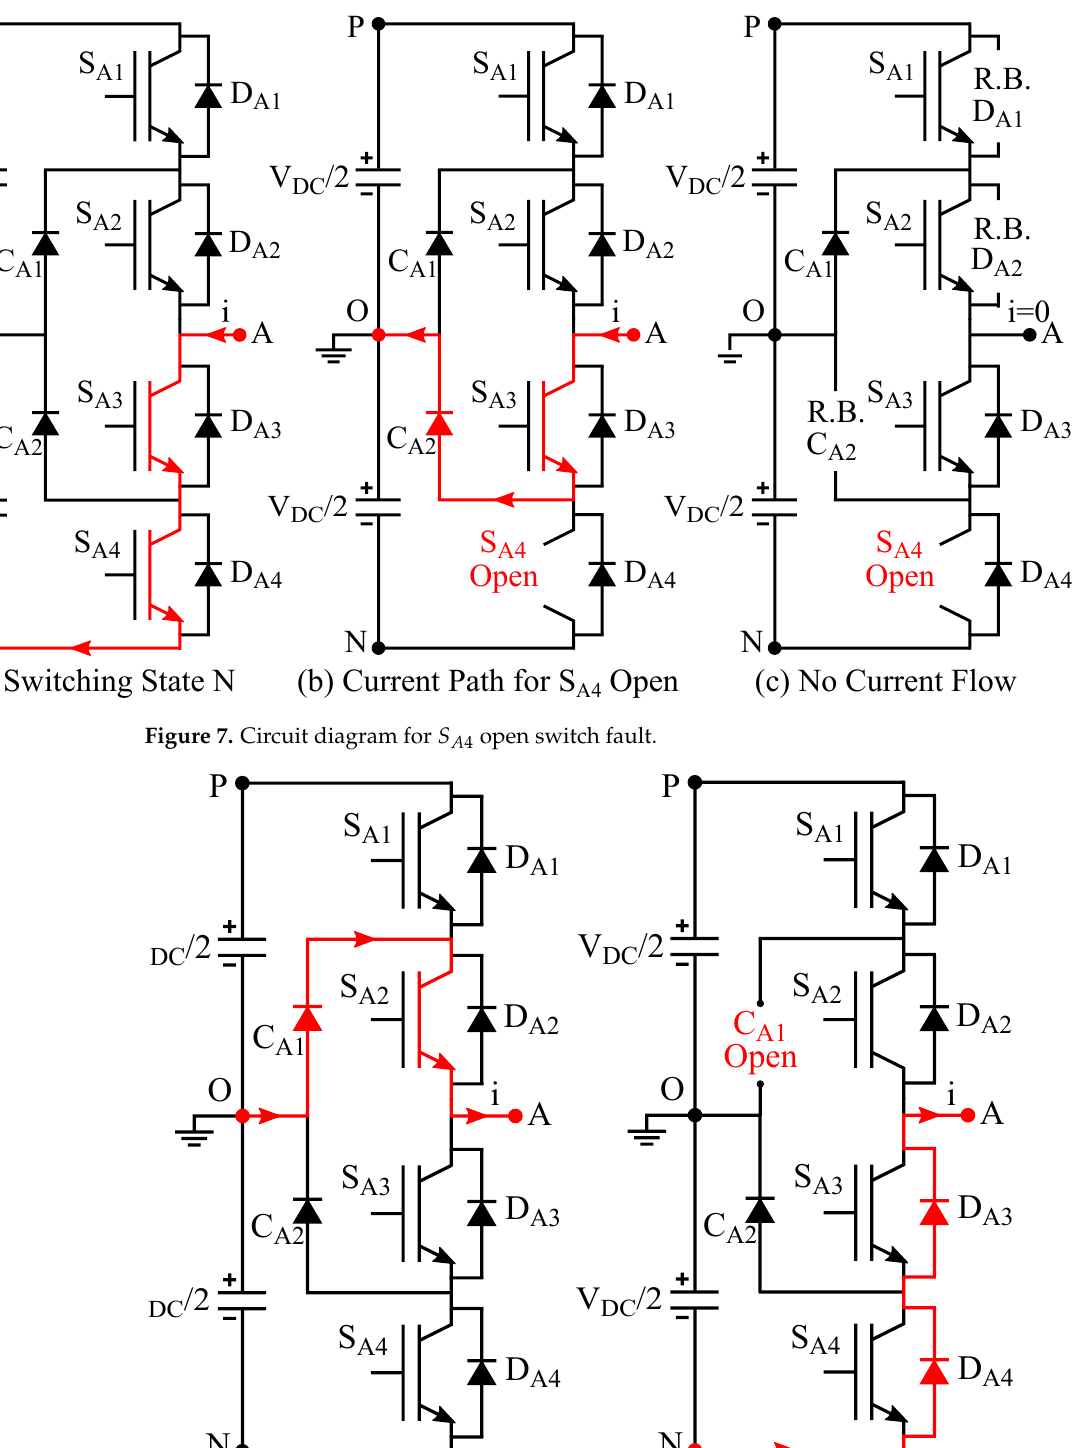
Figure 8. C A 1 OC switch